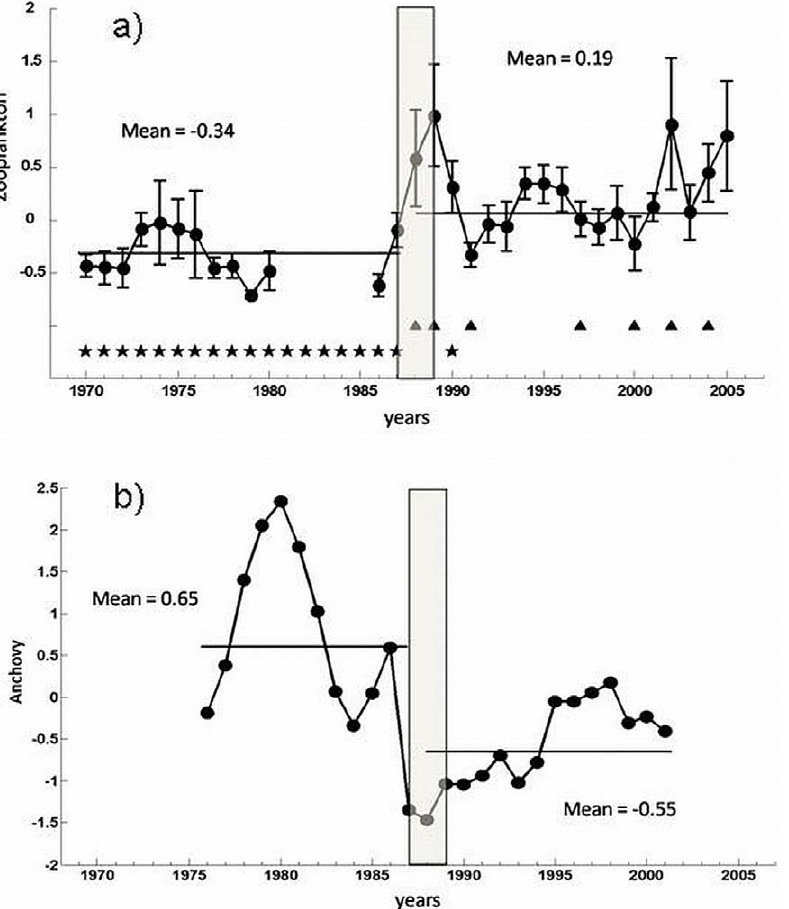
Figure 2. Summary of changes in the Adriatic (eastern Mediterranean) ecosystem at the end of the 1980s. (a): Line: total copepod abundance (standard units) measured in the Gulf of Trieste, 1970–2005. Stars: years in which red tides occurred. Triangles: years in which mucilage events were recorded. (b): anchovy stock biomass (standard units) averaged over the Adriatic Sea. The horizontal lines correspond to the means of the subperiods 1970–1987 and 1988–2005. The vertical grey bar shows indicatively the period of change (late 1980s).